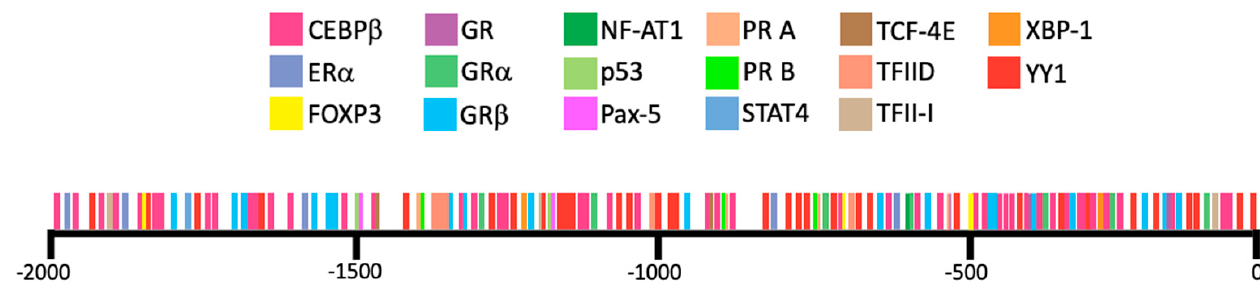
Figure 6. In silico screening of putative transcription factor binding sites for the LGALS16 gene. There are multiple binding sites for 17 transcription factors within the 2 kb promoter region upstream the transcription start site of LGALS16 gene as detected by PROMO.